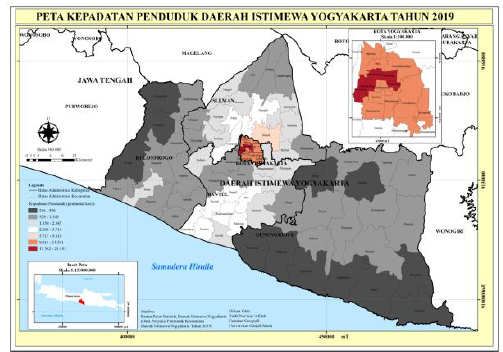
Figure 4.5 Choropleth Map Using the Most Effective Color Symbol Scheme